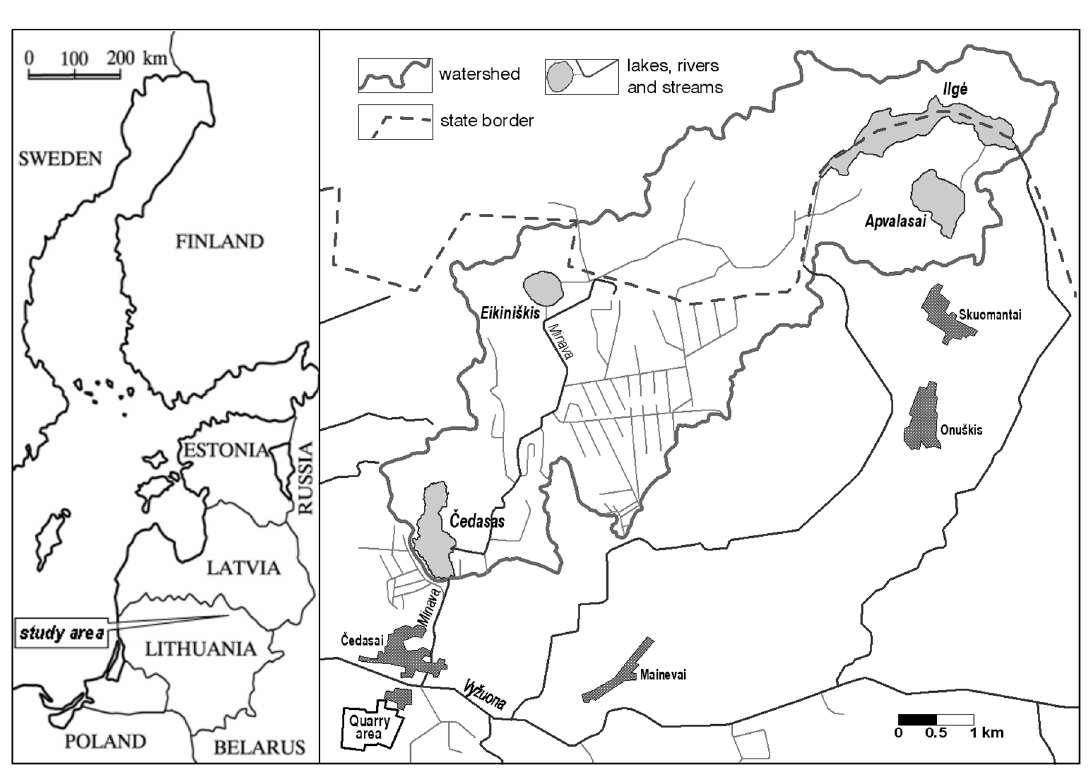
Fig. 1. Study area: the Lake Č edasas watershed and its surroundings.